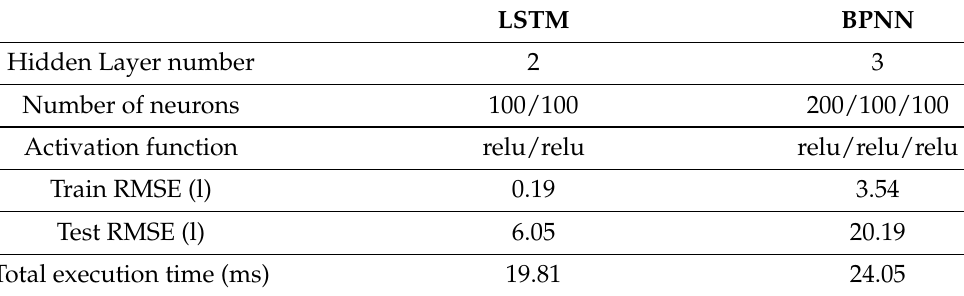
Table 1. Hourly prediction of water consumption in liters with the LSTM and